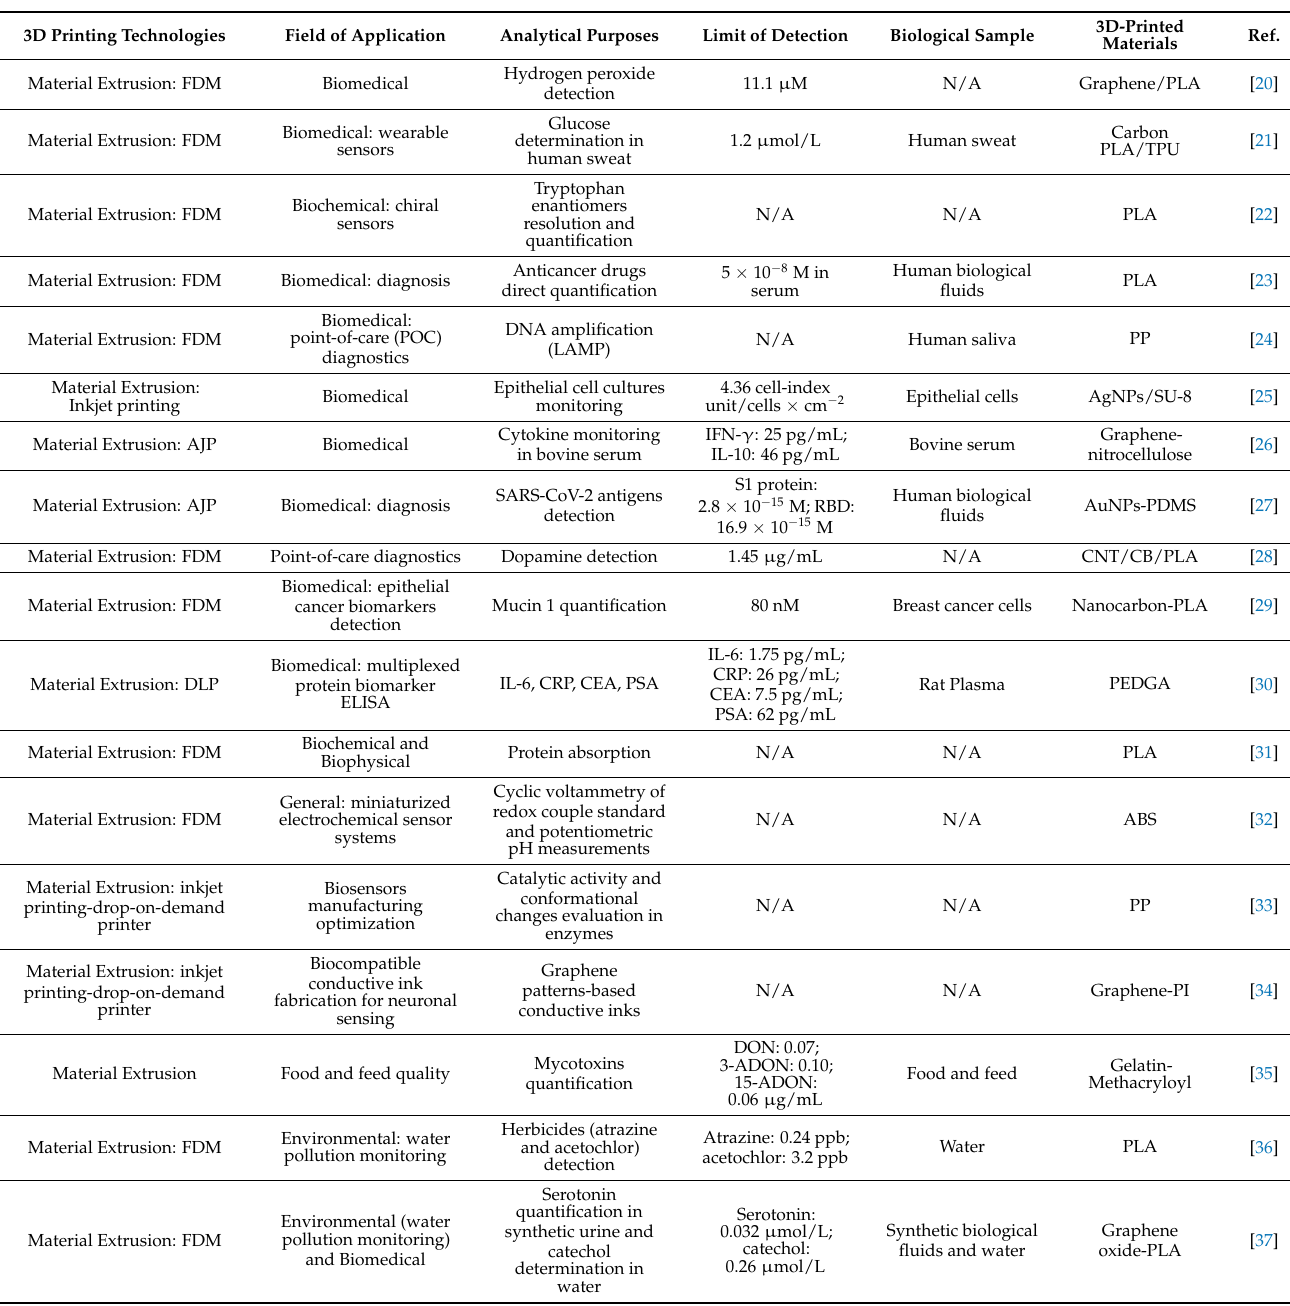
Table 1. 3D printing technologies in biosensors production, their fields of application, and the main analytical purposes. Limits of detection and biological sample of interest are also reported when the information was available in related publications (N/A = not